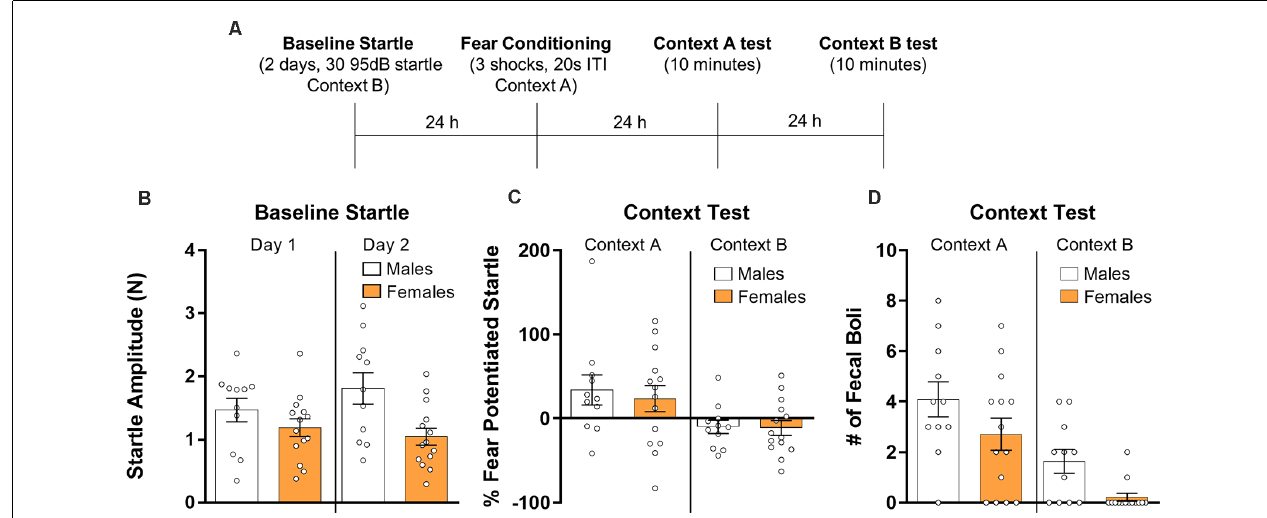
FIGURE 2 | Male ( n = 11) and female ( n = 14) rats were given baseline startle tests on consecutive days and the next day they were exposed to contextual fear conditioning. Rats were then exposed to the training context (Context A) and the next day re-exposed to the startle context (Context B) for 10 min during which fear-potentiated startle was assessed (panel A depicts the timeline of the experiment). (B) Average baseline startle amplitude in males and females during both days of startle testing. (C) Fear potentiated startle in the training context (Context A, right panel) and during a test in the startle chamber (Context B, left panel). (D) The number of fecal boli in males and females during the respective test